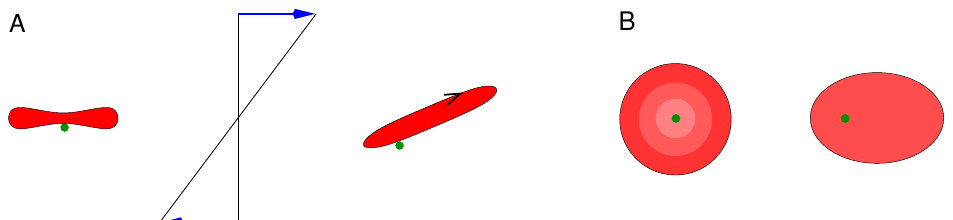
Figure 1. Schematic of the kinematics of the tank-tread (TT) motion. ( A ) View along the vorticity of a simple shear flow (middle). Left, a red cell at rest in edge-on orientation. Right, TTing under the imposed shear flow. The orientation of the elongated cell is almost stable due to a compensation of two turning moments [15]. The (black) arrow indicates the motion of the membrane. The dimple region is marked by a membrane-attached sphere (dark green). ( B ) View along the gradient of the simple shear flow. In an experiment, the TT motion is visualized by a back-and-forth motion of membrane-attached spheres [13].